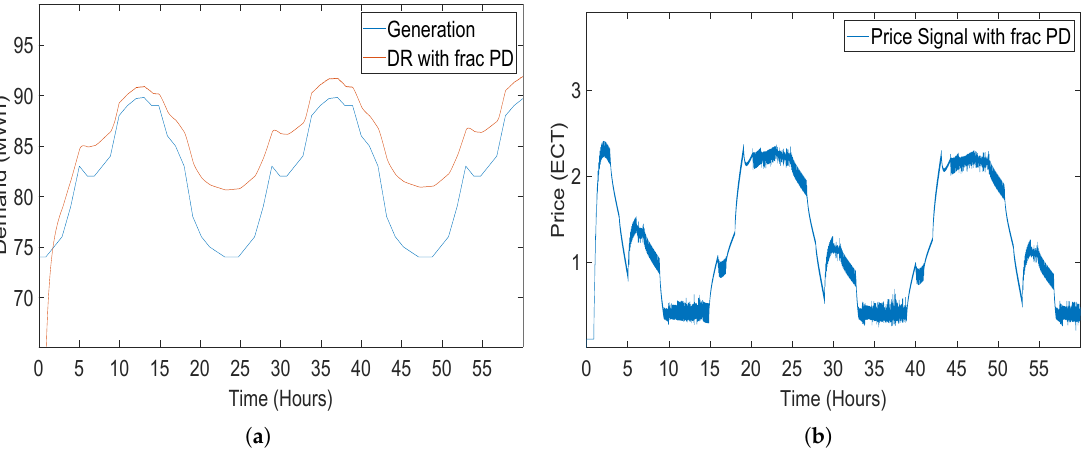
Figure 17. Closed-loop elastic demand control using a fractional order proportional derivative (FOPD) controller having coefficient values K p = − 0.2, K p = − 0.3 and α = 0.3: ( a ) demand response; ( b ) price